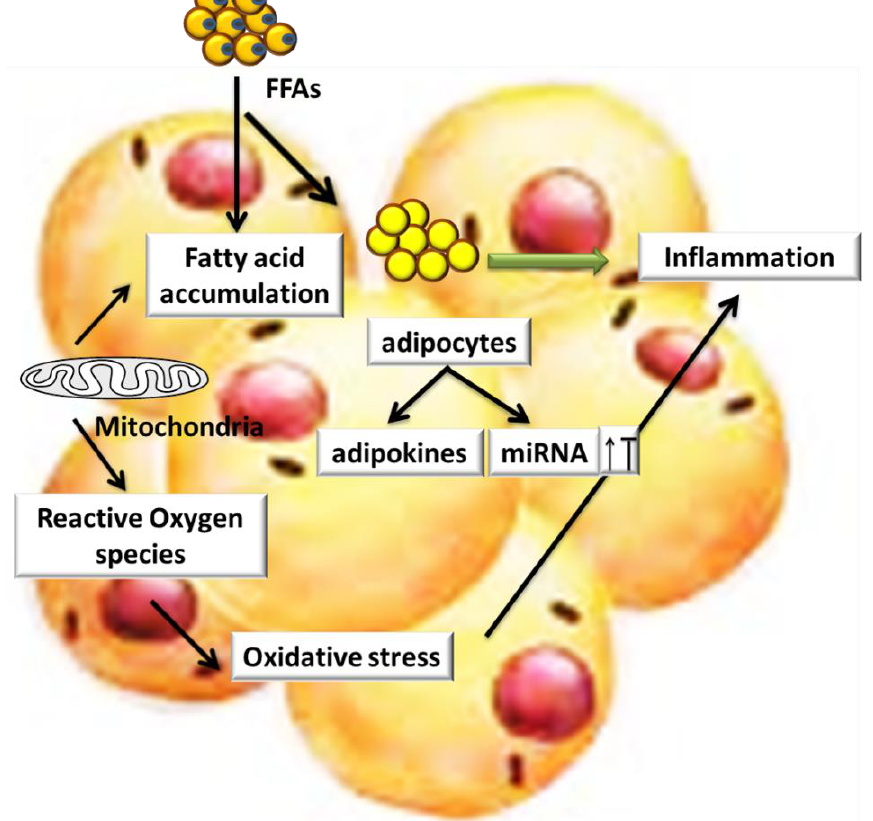
Figure 2. ROS and Obesity: In obese individuals, access supply of free fatty acid (FFA) toward mitochondria results in an increase in the production of ROS and OS, which leads toward inflammation; adipokines and miRs are also associated with OS and inflammation.